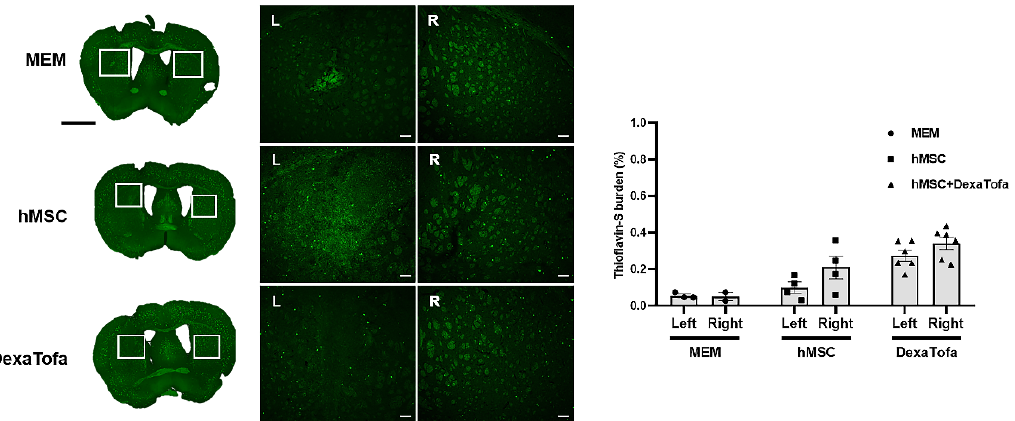
Figure 7. Thioflavin-S staining of the left and right caudate putamen. Representative Thioflavin-S- stained tissue images of the MEM ( n = 3), hMSC ( n = 4), and DexaTofa ( n = 6) groups acquired via Vectra (whole brain) and confocal microscopy (magnified image). Green dots (fluorescence signal) indicate location of amyloid plaques. Scale bars = whole brain: 2 mm, magnified inset area = 100 µm. (L vs. R) mean ± SEM (two-way ANOVA, Tukey’s multiple comparison).